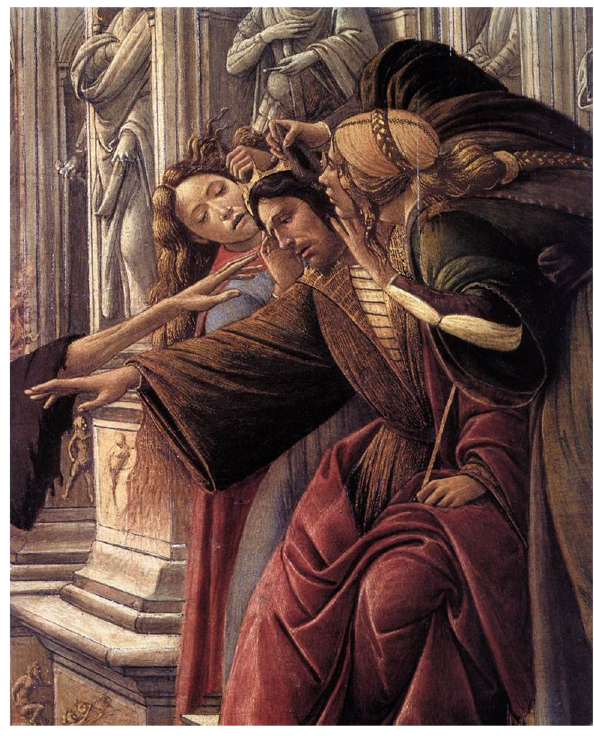
Figure 12: Botticelli, Calunnia . Detail.